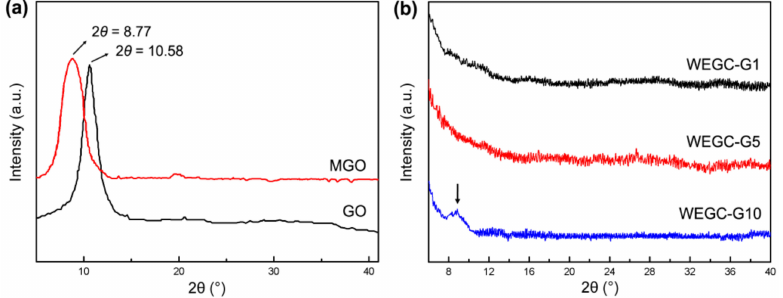
Figure 3. X-ray di ff raction (XRD) patterns of ( a ) graphene oxide (GO), modified graphene oxide (MGO), and ( b ) waterborne epoxy-GO coatings